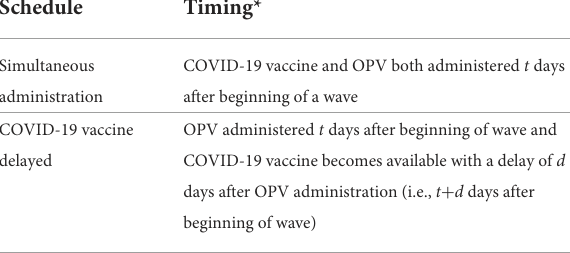
TABLE 1 Two immunization schedules adding OPV to COVID-19